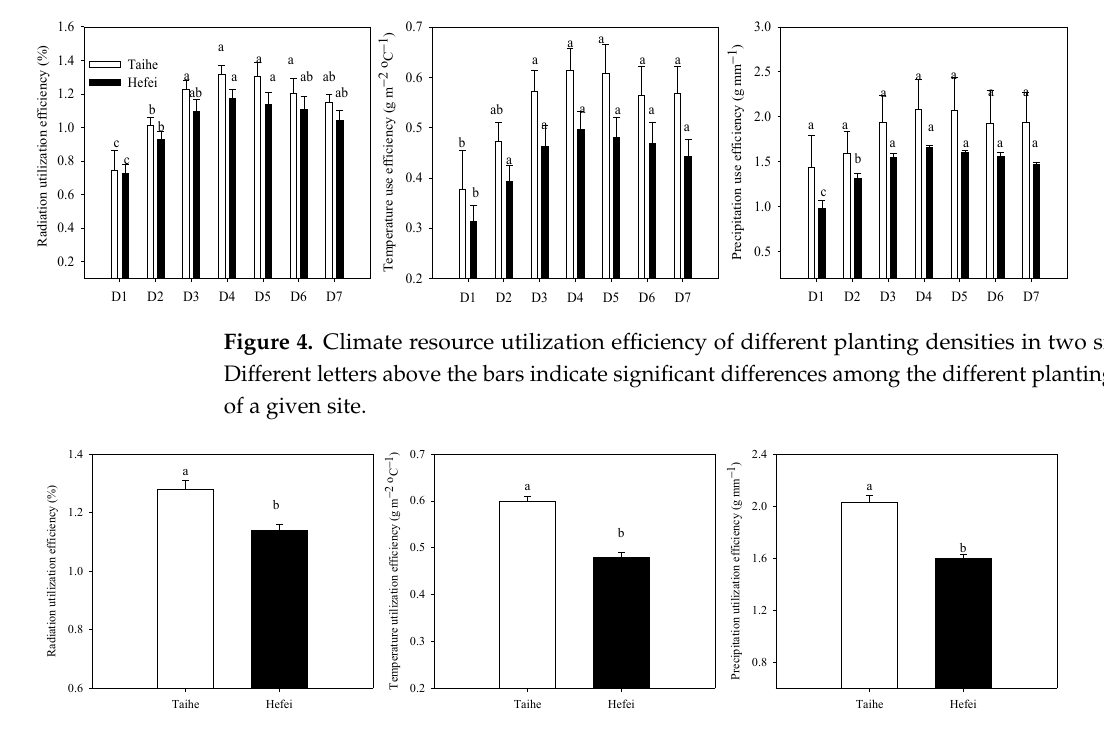
Figure 5. Comparison of climate resource utilization efficiencies between Taihe and Hefei. Note: Different letters above the bars indicate significant differences between different sites. The correlation between solar radiation, AT 10 , precipitation, and grain yield was an- alyzed. A positive relationship between solar radiation and grain yield (R = 0.349, p < 0.01) and a negative relationship with AT 10 (R= −0.535, p < 0.01) were found, while there was no significant relationship between precipitation and grain yield (R = −0.147, p = 0.217). A stepwise multiple linear regression model was used to analyze solar radiation, AT 10 , and grain yield. The regression equation wa s y = 0.550R−0.562 AT 10 + 14,593.6 (R = 0.379). In conclusion, the grain yield was positively affected by solar radiation and negatively af- fected by AT 10 .